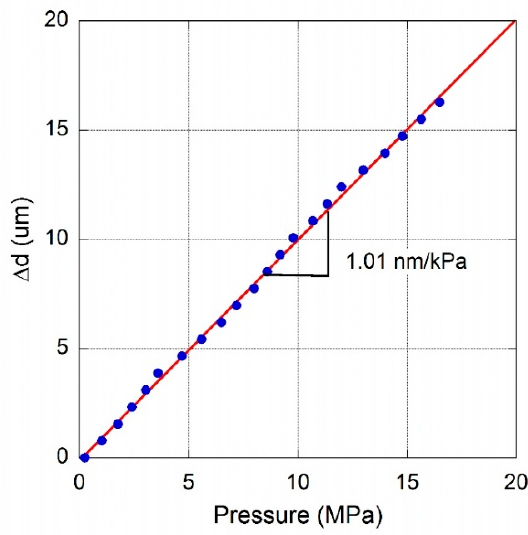
Figure 12. Membrane deflection as a function of pressure difference evaluated at minimum of signal of a measurement performed up to 16.5 MPa for a PCD membrane having a diameter of 380 μ m.